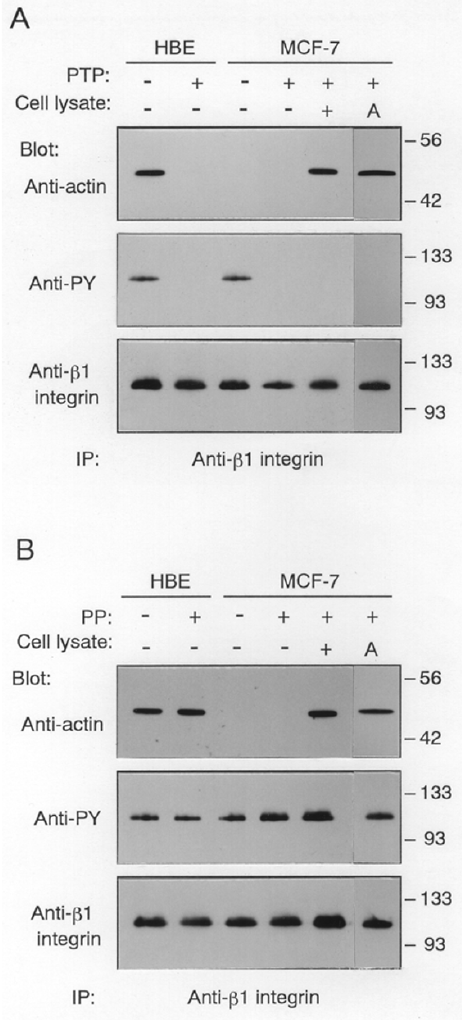
Figure 5 Effects of dephosphorylation of β 1 integrin on its coprecipitation with actin. (A) The β 1 integrin immuno- precipitates from quiescent HBE or MCF-7 cells were treated with (+) or without (-) PTP, then immunoblotted with anti-actin, anti- β 1 integrin, or anti-PY antibody. The PTP-treated β 1 integrin immunoprecipitates from MCF-7 cells were incubated for 30 min with (+) or without (-) the supernatant of the β 1 immunoprecipitates containing unbound actin (Cell lysate), or with 5 µ g/ml exogenous human platelet actin (A). Molecular size markers are indi- cated at right in kDa. (B) The β 1 integrin immunoprecipitates from quiescent HBE or MCF-7 cells were treated with (+) or without (-) PP2A 1 , then the PP2A 1 -treated β 1 integrin from MCF-7 cells were incubated for 30 min with (+) or without (- ) the supernatant of the β 1 immunoprecipitates (Cell lysate), or with 5 µ g/ml exogenous human platelet actin (A). The immunoblots were probed with anti-actin, anti- β 1 integrin, or anti-PY antibody. Molecular size markers are indicated at right in